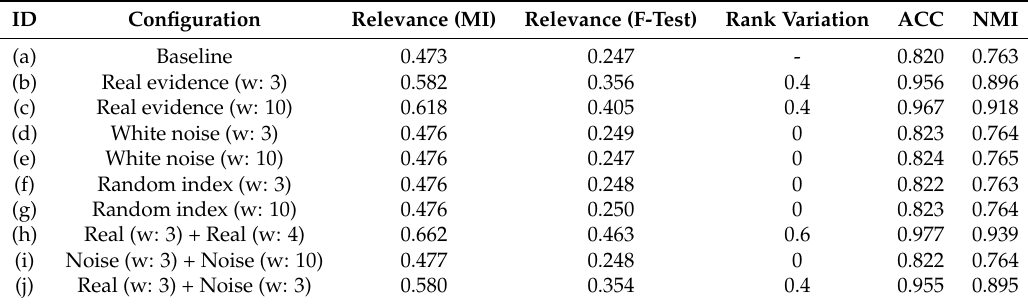
Table 1. The MNIST dataset results: W indicates the number of classes represented by the each evidence sample vector. Real evidence with width 3 represents the relation of y mod 3, while width 4 represents hash ( y ) mod 4 and width 10 represents y , with y being the digit label for all instances. For comparison purposes, we report the normalised F-test values using l2 norm.